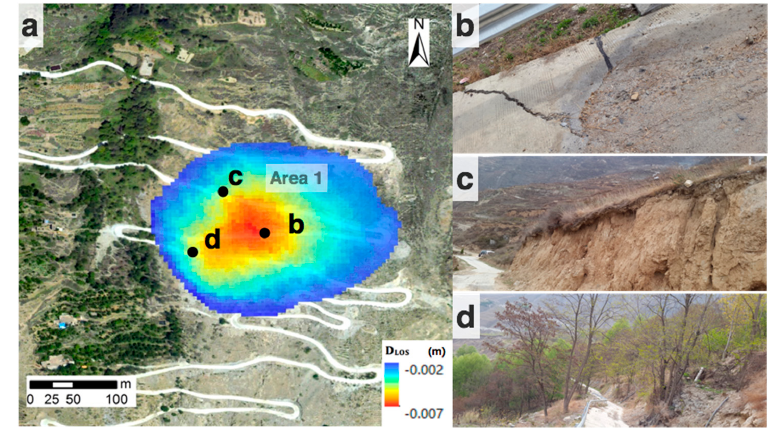
detectable gradient.